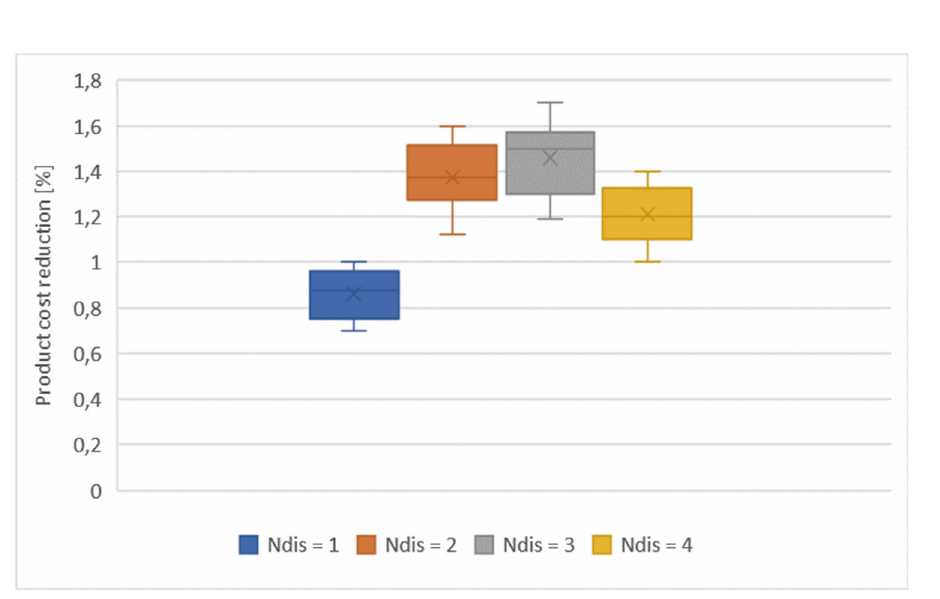
Figure 8. Box plots related to cost reduction peaks for every simulated number of operators